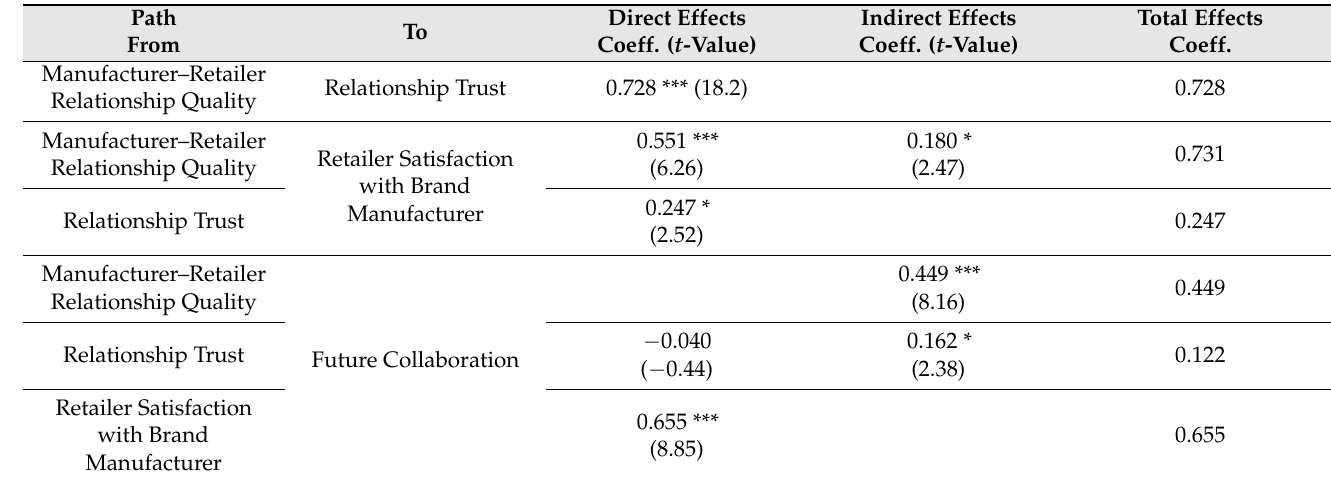
Table 9. Direct, Indirect, and Total